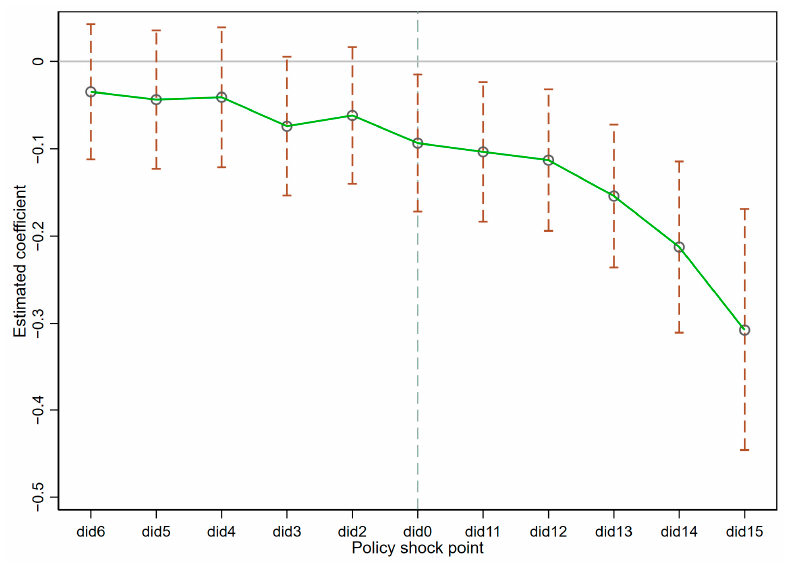
Figure 2. Parallel trend test.